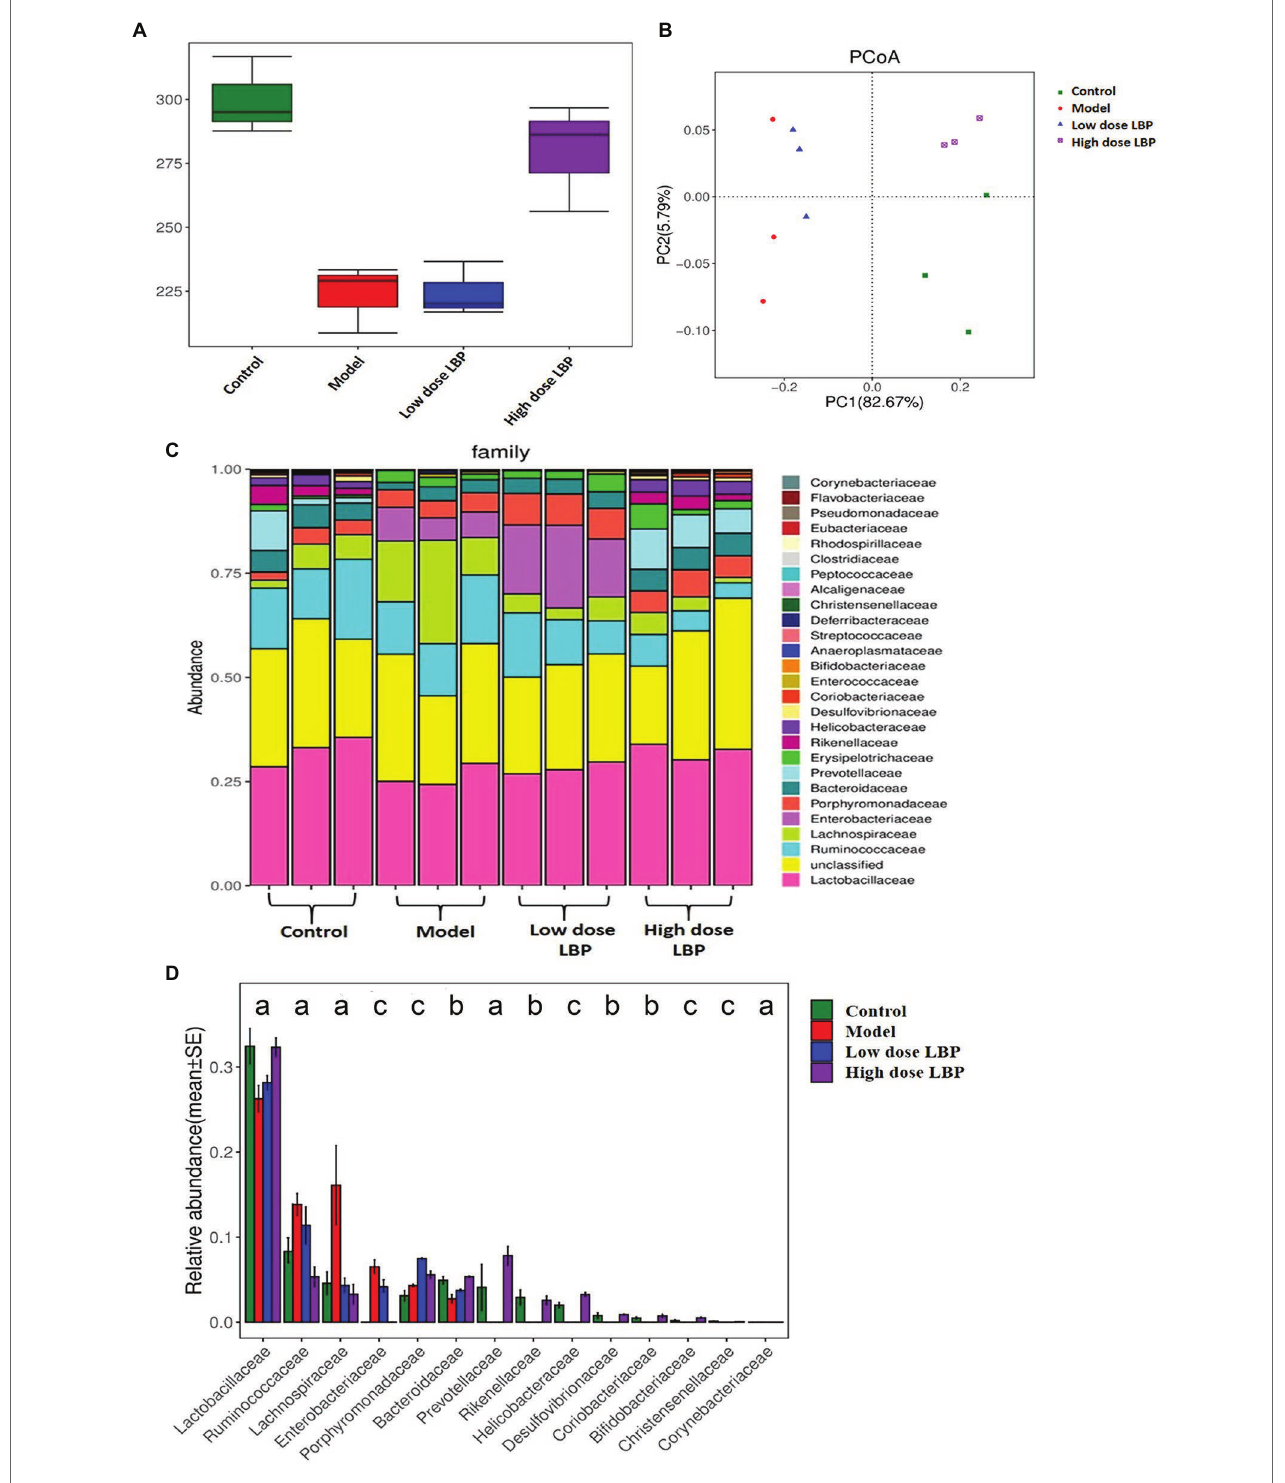
FIGURE 5 | Lycium barbarum polysaccharide’s effects on fecal microbiome. Data are presented as mean ± SD ( n = 3). (A) Fecal taxon richness evaluated by α -diversity analysis based on the ace technique. (B) β -diversity (Unifrac) of fecal microorganisms, based on principal coordinates analysis (PCoA) of the Unifrac distance matrices. Every dot represents a specimen, and groups are distinguished by colors (green, control; orange, model; blue, low dose LBP; and purple, high dose LBP). (C) Microbiome taxon composition at the family level. (D) Analysis of the differences among the experimental groups based on gut microbiota composition at the family level ( a p < 0.05, b p < 0.01, and c p <